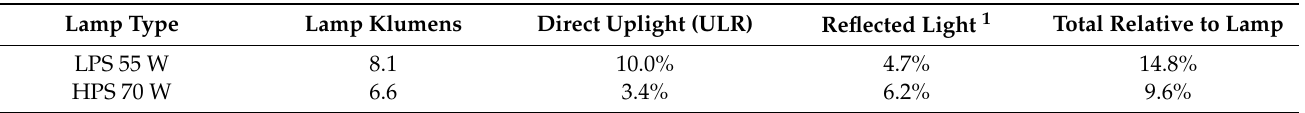
Table 1. Photometry for two representative lantern types: a linear LPS lantern with refractive lens and a drop-bowl semicutoff HPS lantern. Lamp